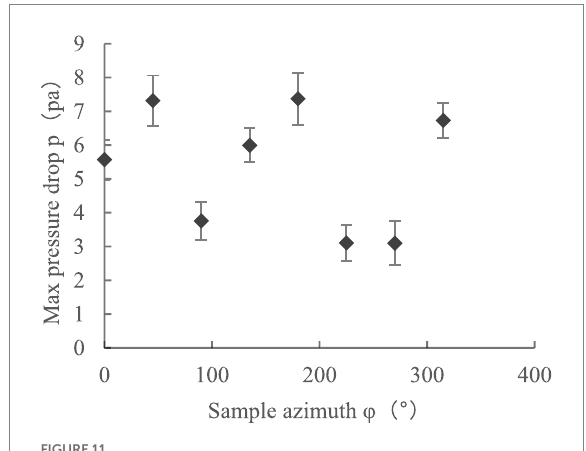
FIGURE 11 Variation of maximum canopy pressure drop with initial azimuth.